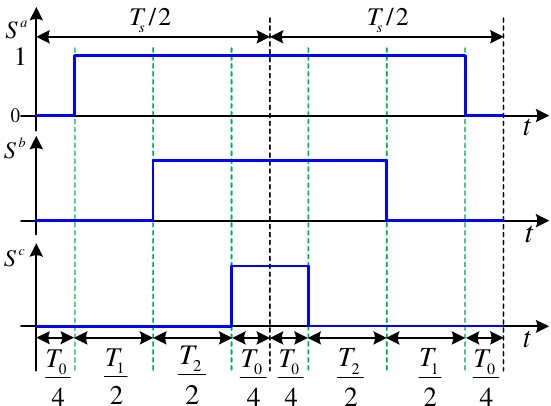
Figure 6. Switching pulses of the power converter in one sampling period. Disturbance